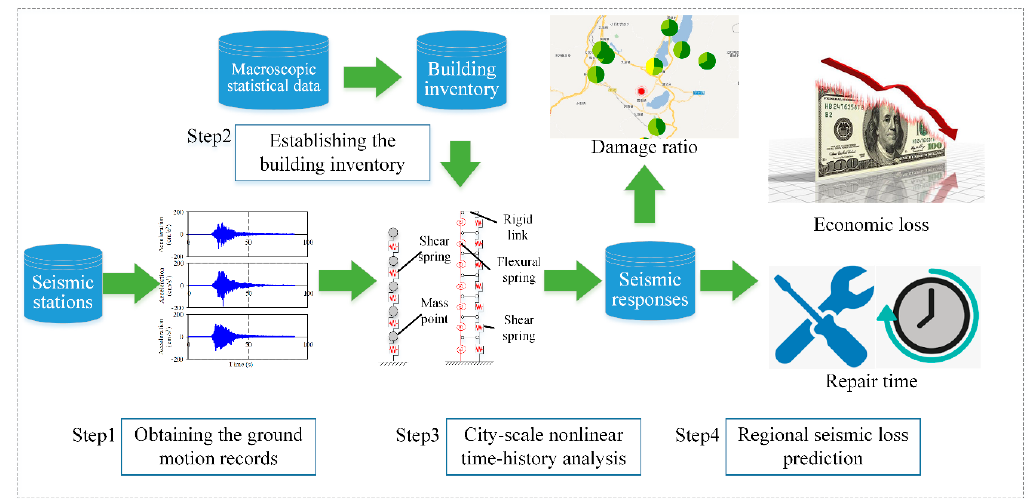
Figure 1. Framework for real-time city-scale time-history analysis and loss assessment.